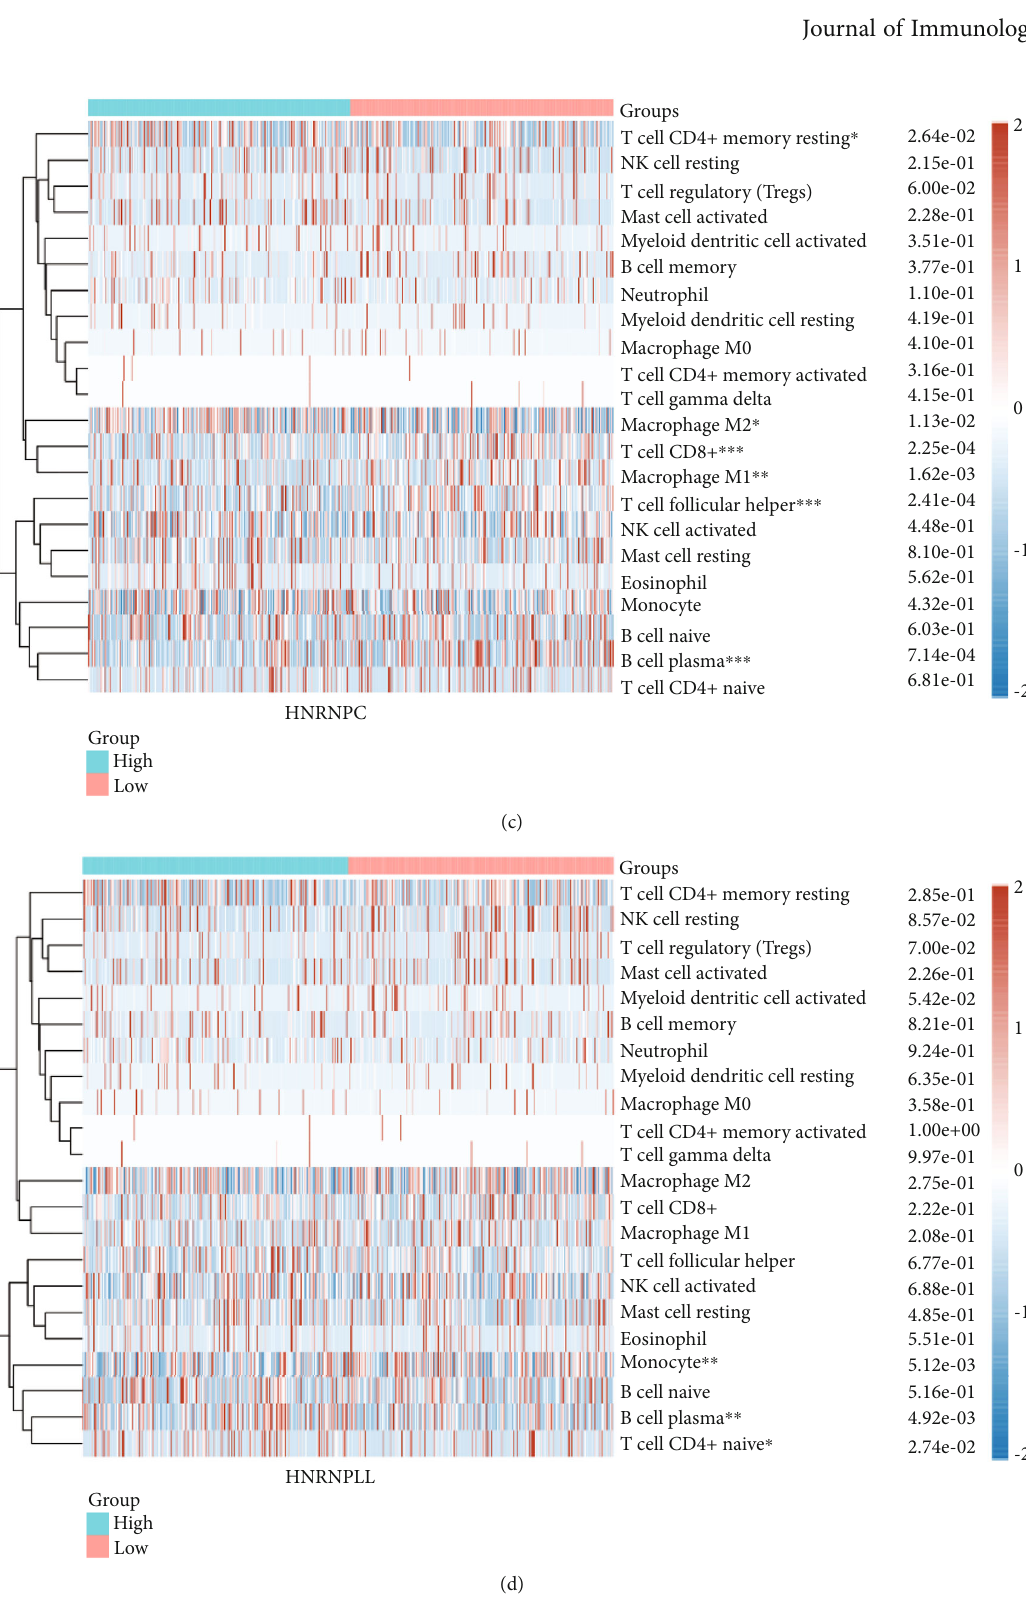
Figure 8: The di ff erence of in fi ltrating immune cells between high and low gene expression with the CIBERSORT